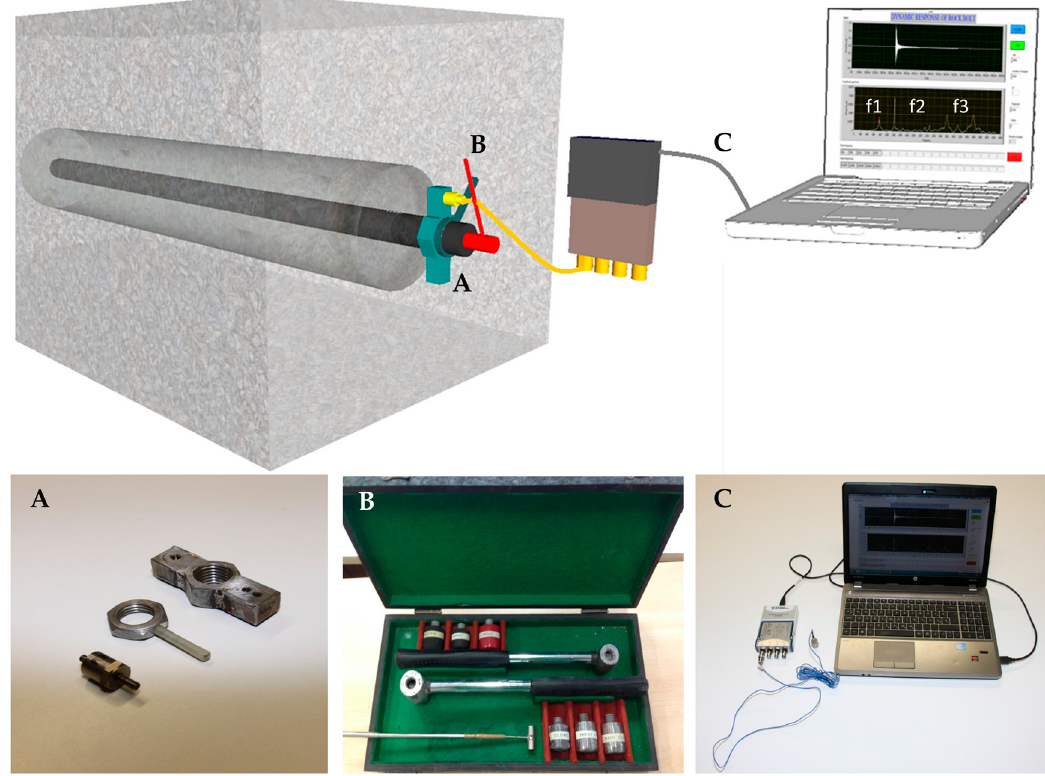
Figure 8. Elements of acquisition equipment: ( A ) a custom made nut with accelerometer; ( B ) a hammer for generation of impulse and ( C ) a laptop with developed state machine and a vibration input module.